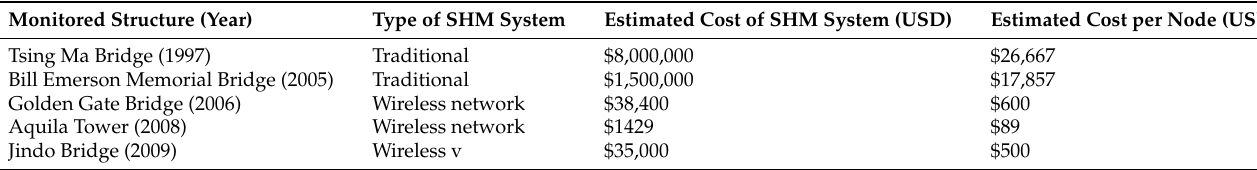
Table 1. Comparison of costs for SHM